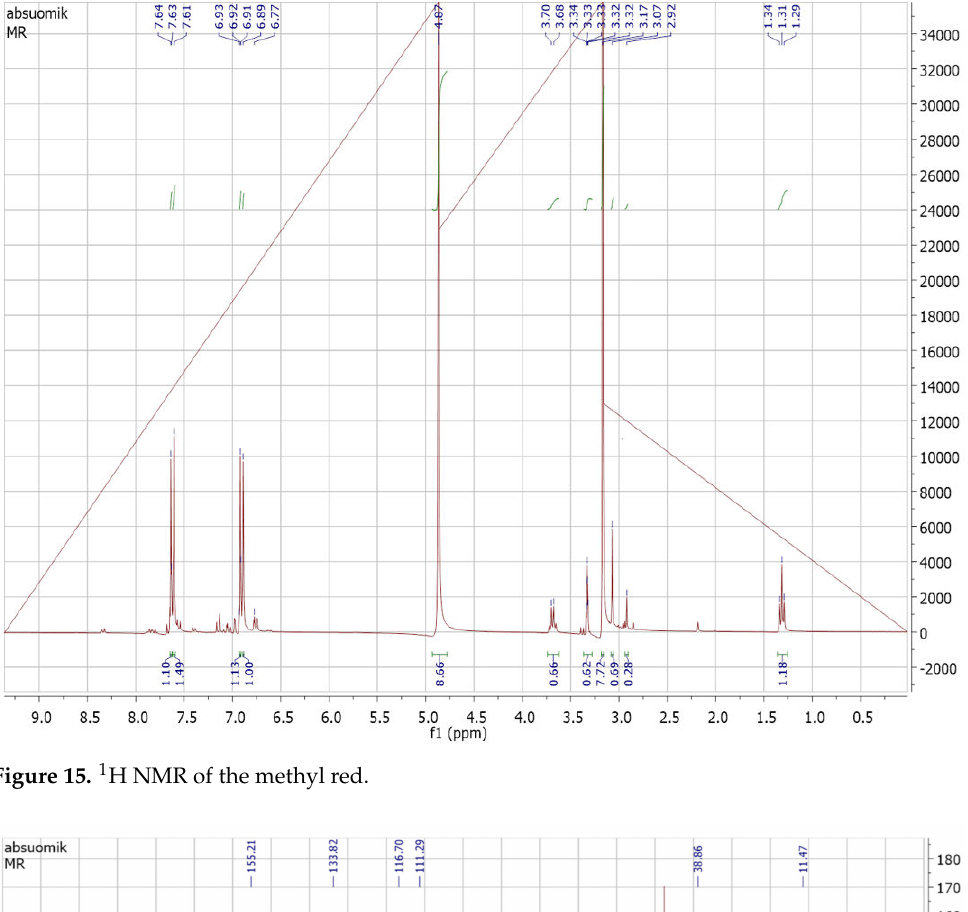
Figure 15. 1 H NMR of the methyl red.